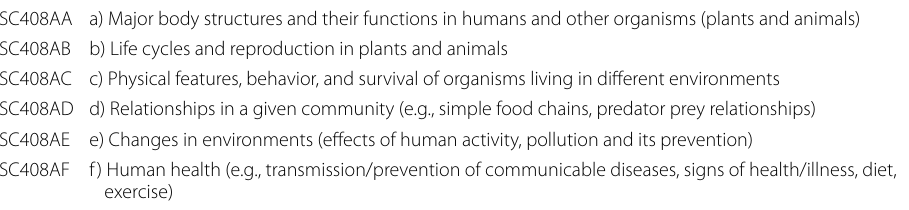
Table 1 Topic areas described in the Curriculum Questionnaire (Source: International Ver- sin of the TIMSS 2011 Background and Curriculum Questionnaires Supplement 1, pp. 155–